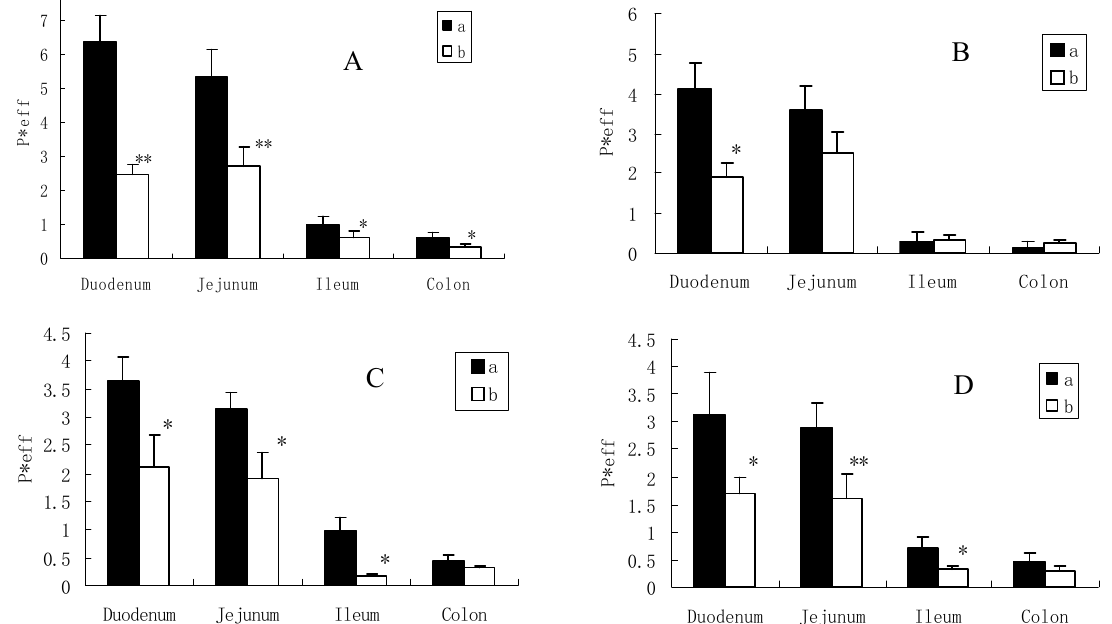
A, B, C, D indicate icarrin, epimedin A, epimedin B, epimedin C, respectively; a: 10 μ M alone; b: addition of inhibitor; Data are expressed as mean ± SD (n = 4). The statistically significant difference (as shown by the asterisk symbol) is between the absence and presence of LPH inhibitor. **P < 0.01, * P <